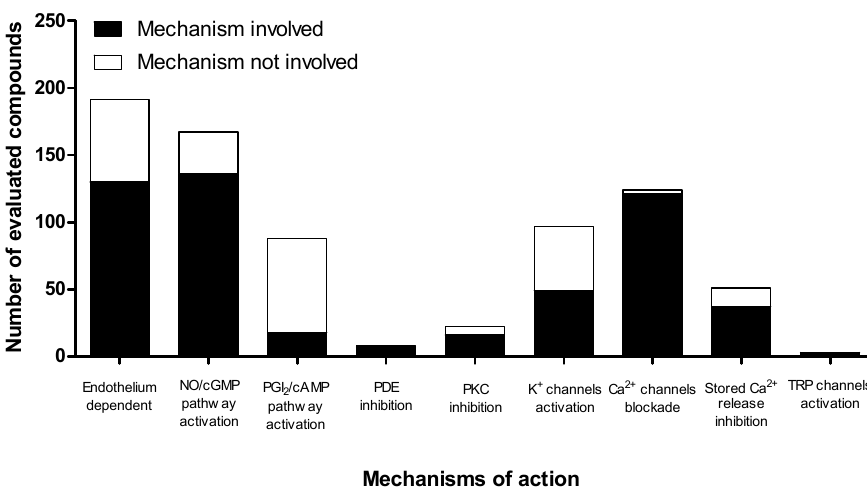
Figure 2. Classification of compounds obtained from plants according to the main mechanism(s) of action involved in their vasodilator